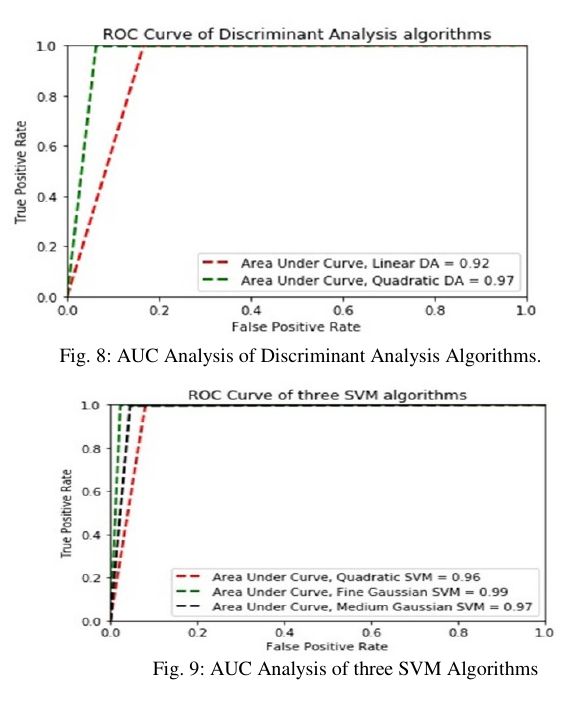
Fig. 9: AUC Analysis of three SVM Algorithms